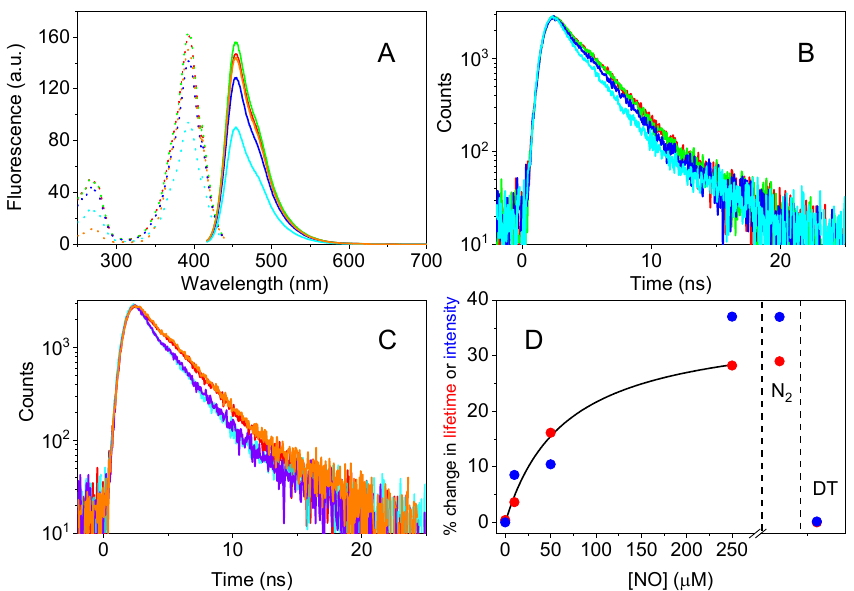
Figure 1. ( A ) Fluorescence excitation (dotted lines) and emission (solid lines) spectra of mTagBFP2 in PBS after deoxygenation with N 2 (red) and at different NO concentrations: [NO] = 10 µM (green), [NO] = 50 µM (blue), and [NO] = 250 µM (cyan). The sample was then exposed to N 2 flow for three hours and subsequently reduced with Na dithionite (2 mM), recovering initial properties (orange curves). For emission spectra λ ex = 400 nm and for excitation spectra λ em = 460 nm. ( B ) Time-resolved fluorescence (TCSPC) for mTagBFP2 in PBS. The color code is the same as in panel (A). Excitation for time-resolved fluorescence was at 380 nm, and detection at 460 nm. ( C ) Reversibility of the time-resolved fluorescence signal after exposure of mTagBFP2 to NO. The curves refer to mTagBFP2 in PBS after deoxygenation with N 2 (red), in the presence of [NO] = 250 µM (cyan), after flowing N 2 for 1 h (purple), and after reduction with Na dithionite (orange). ( D ) Percent change in an average lifetime (red circles) and fluorescence emission intensity (blue circles). The black solid line is the result of the fit of the lifetime data with a model for binding of NO to the protein. The plot also shows the effect of N 2 saturation for 1 h (N 2 ) and the subsequent reduction with Na dithionite (DT). The experimental values for percent change in fluorescence lifetime and intensity after Na dithionite reduction coincided.